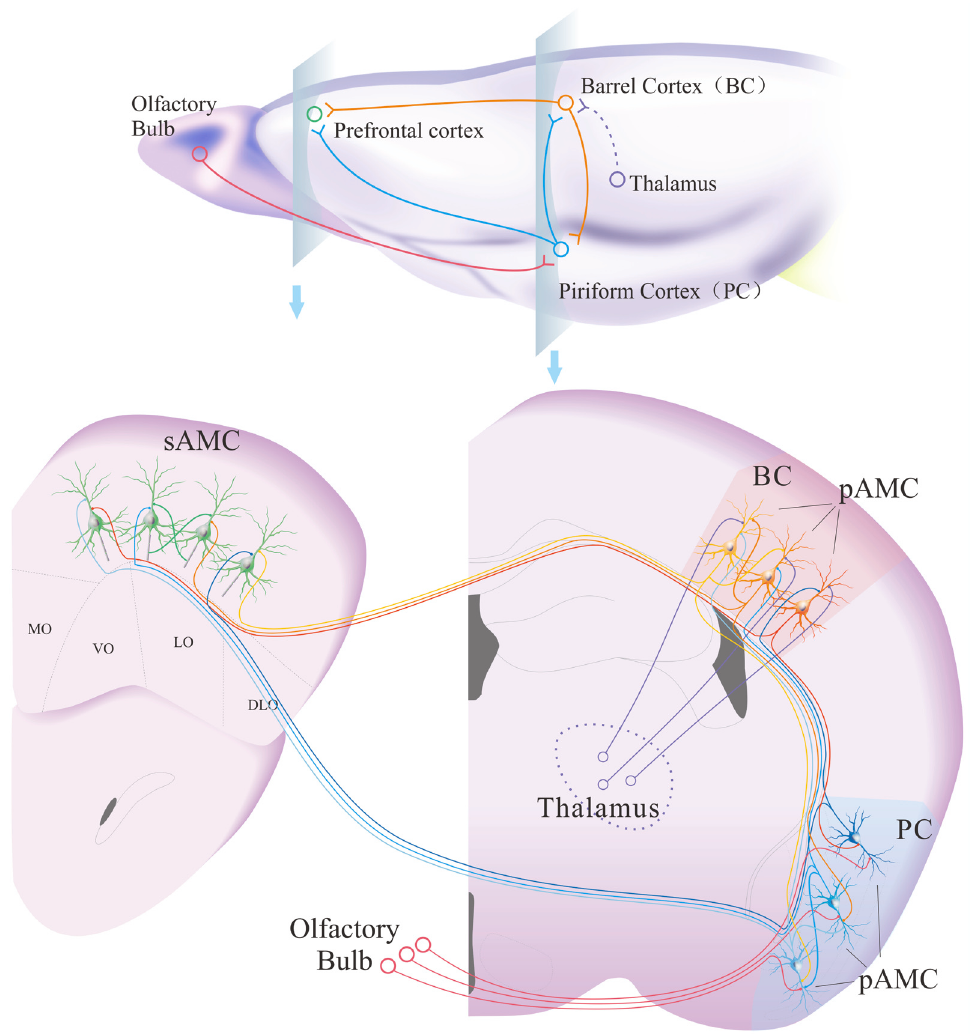
Figure 1. The associated activation of the sensory cortices recruits their mutual innervations and associative memory cells. Associative memory cells encode new sensory signals alongside innate signals, which are called primary associative memory cells (pAMC). They receive synapse innervations from co-activated sensory cortices alongside innate sensory inputs. Their axons project to the brain areas related to cognition (prefrontal cortex and hippocampus), emotions (amygdala and nucleus accumbens) and behaviors (motor cortex). The downstream neurons can be mutually innervated to encode dual associative signals (secondary associative memory cells, sAMC) during active thinking. sAMC also include those neurons that receive convergence inputs from different groups of pAMC. The mutual innervations can be induced among the different groups of pAMC by the associations of their correspondent intramodal signals. The different groups of associative memory cells and their inputs/outputs are presented by the different intensities of colors, such as light blue vs dark blue and orange vs